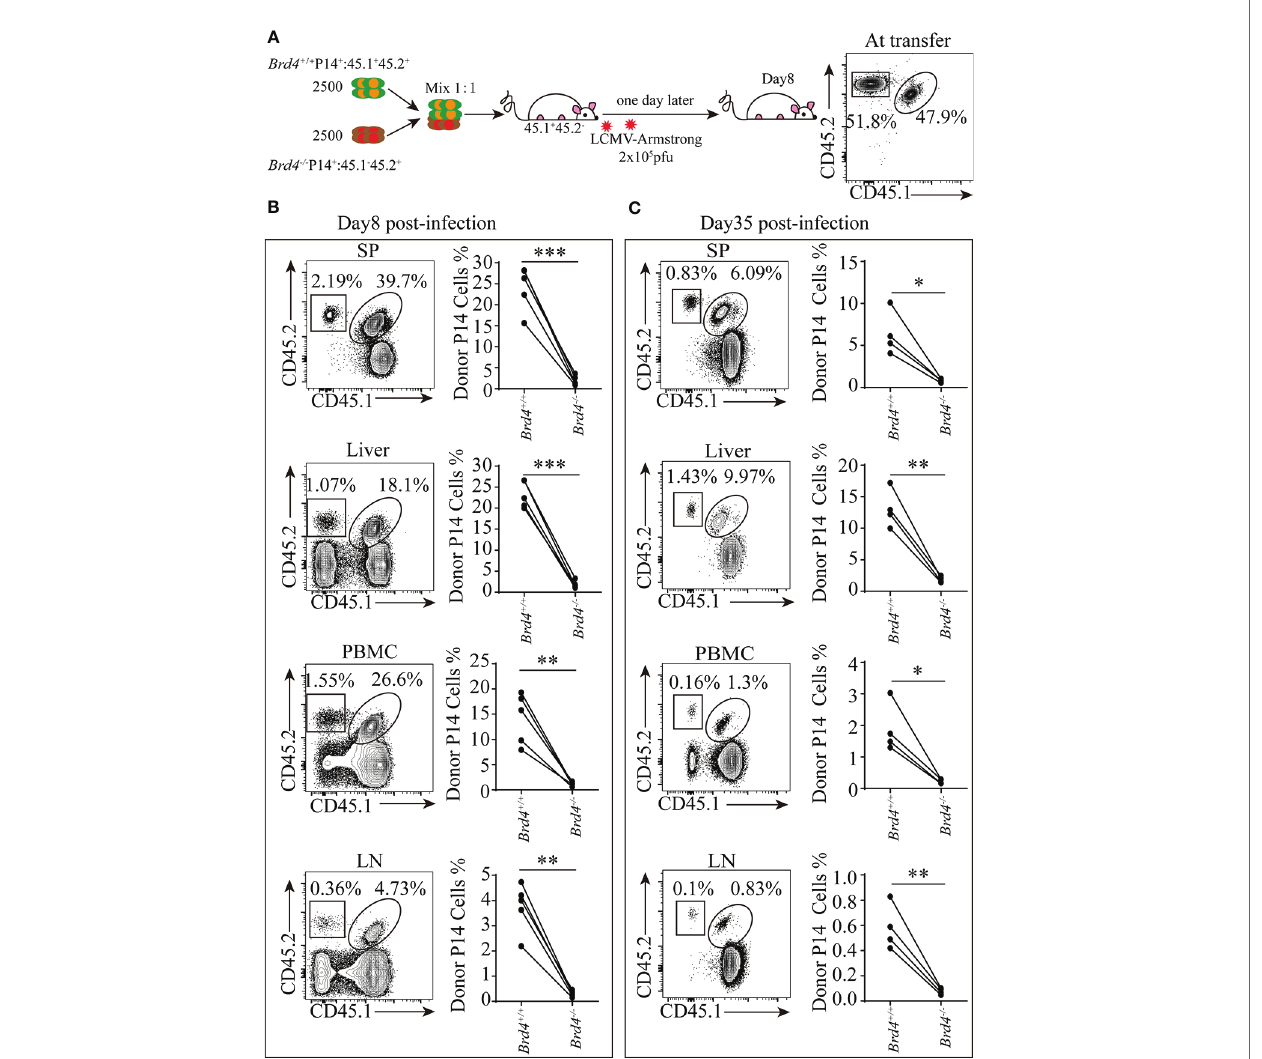
FIGURE 3 | Brd4 promotes the clonal expansion of CD8 + T cells during viral infection. (A) Experiment setup. (B) Brd4 +/+ and Brd4 -/- effector P14 + CD8 + T cells recovered at day 8 in indicated tissues (left) and the quanti fi cation of effector P14 + CD8 + T cells post-infection (right). (C) Brd4 +/+ and Brd4 -/- memory P14 + CD8 + T cells recovered at day 35 in indicated tissues (left) and the quanti fi cation of memory P14 + CD8 + T cells post-infection (right). Paired Student ’ s t -test was used to analyze data. Results were indicated as mean ± sem (error bars). *p < 0.05; **p < 0.01; ***p < 0.001. Each group includes at least 4 mice and each experiment repeats more than 3